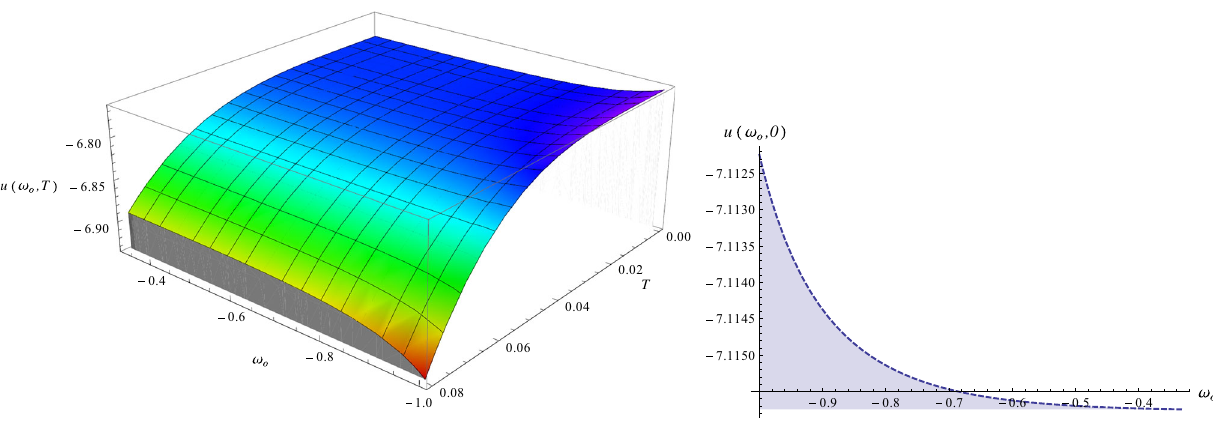
Fig. 2 u 0 ((cid:3) o , T ) and u 0 ((cid:3) 0 , 0 ) depicted at the equator (multiplied by 10 3 ) for a set of parameters: r = 10, (cid:13) = 2 ω d , θ = π/ 2, α o = 0 . 001, (cid:3) = − 2 / 3 ,α = γ m 2 γ = 10 − 3 , m = 1, L = k = g p B 2 2 g ,